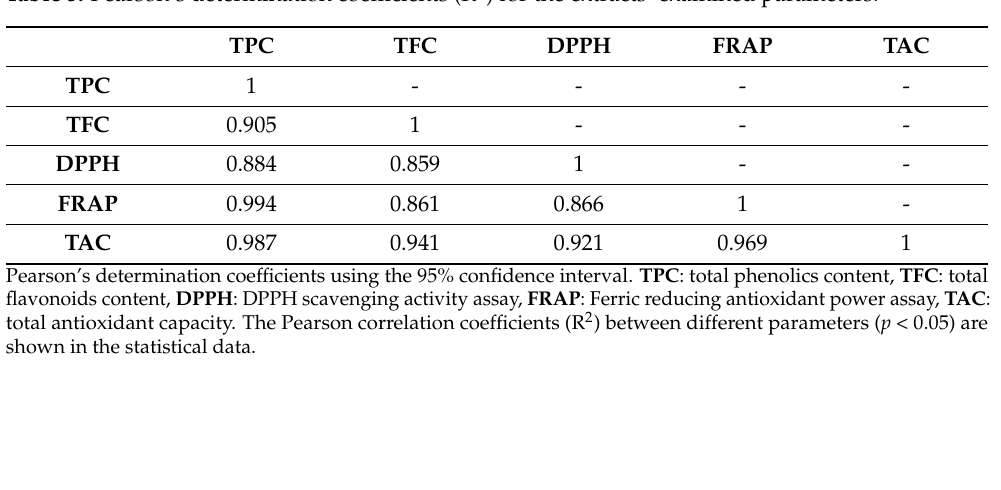
Table 5. Pearson’s determination coefficients (R 2 ) for the extracts’ examined parameters.